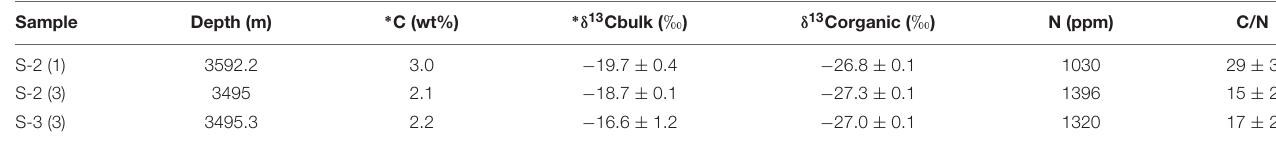
TABLE 2 | Bulk composition of samples in terms of carbon (C) and nitrogen (N) concentration, δ 13 C (bulk and organic), and atomic C/N ratios.